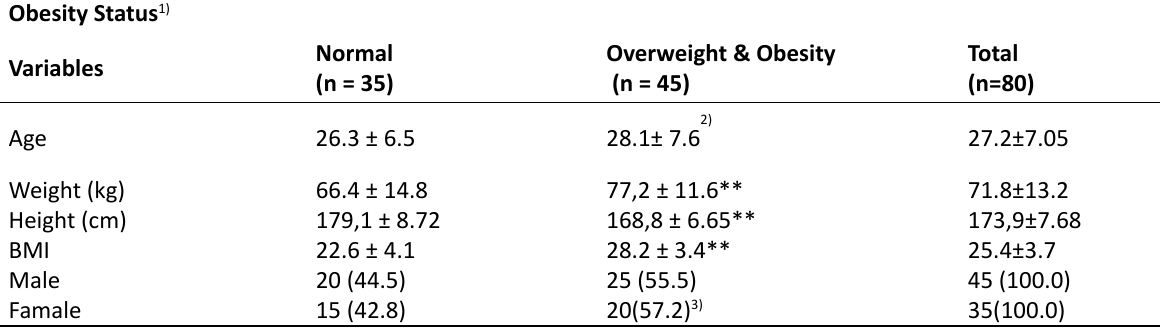
Table 1. General Descriptive Characteristics of Sedanter Individuals Who Are Members of Fitness